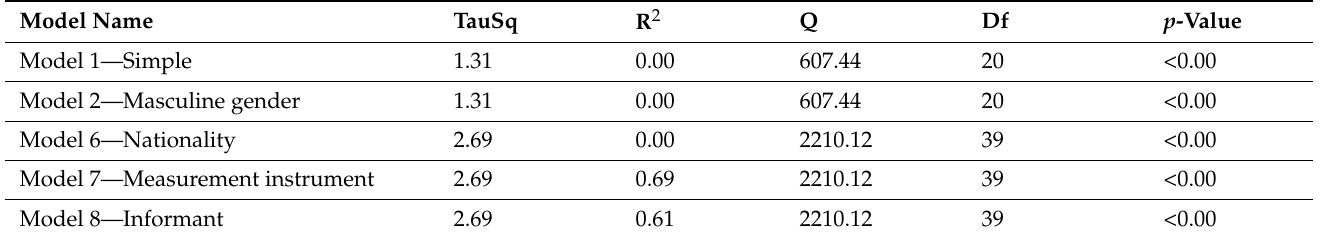
Table 2. Model comparison: Random effects (MM), Z-distribution, Fisher’s